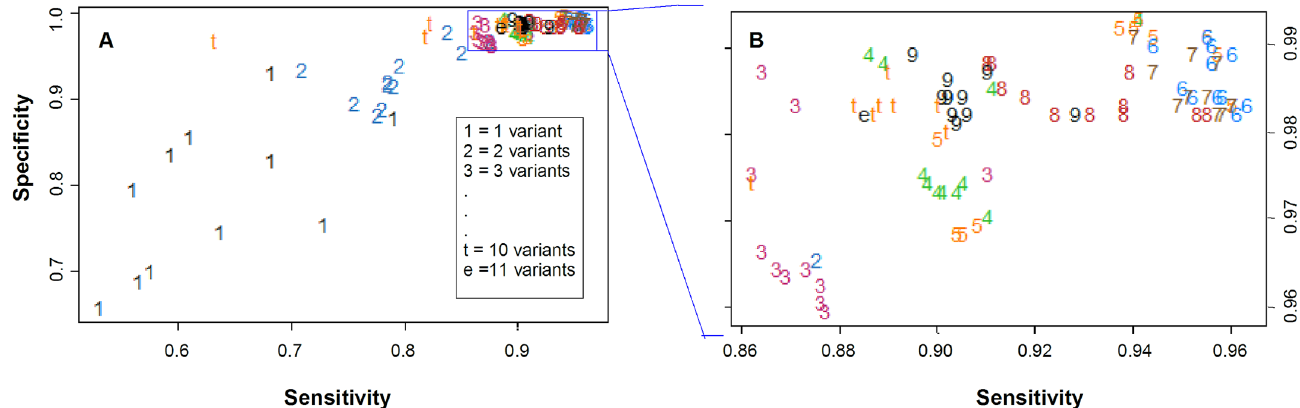
Fig 7. Sensitivity and specificity increase by using groups of 5–7 variables. Eleven variables (CFU and Δ Ct data) from the complete data set were used alone or in multiple combinations to generate 2047 experimental models; each model therefore included between 1 and 11 variables. The sensitivity and specificity for a subset of all the models were calculated and plotted (Panel A). This subset was generated by dividing the experimental models into eleven groups according to the number of variables used, and by selecting the top eleven scorers for each group. Plots using numbers or letters indicate the number of variables used in each model, where t and e correspond to 10 and 11 variables, respectively. The area within the rectangle in the upper right hand corner of Panel A corresponds to the highest values of sensitivity and specificity and is enlarged for presentation in Panel